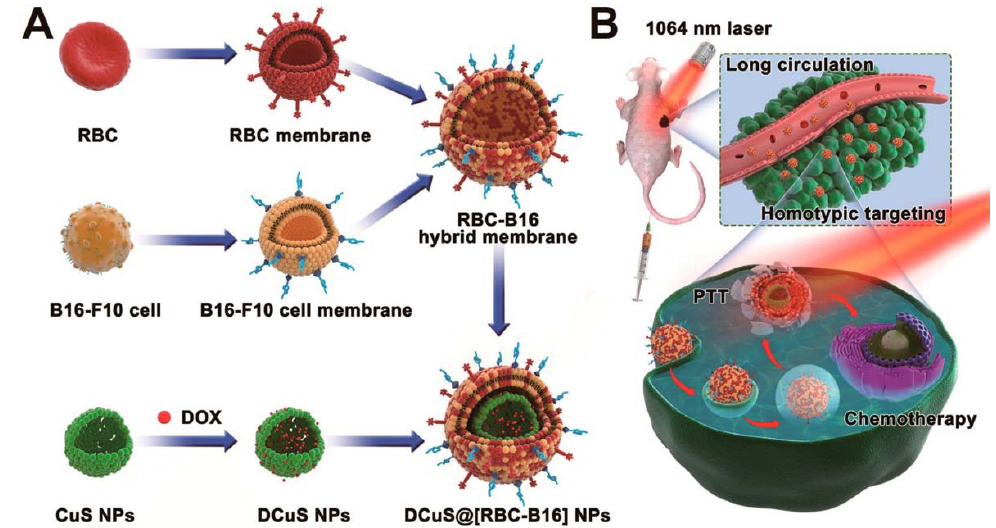
Figure 10. Schematic showing the fusion of RBC and cancer cell membranes and camouflaging Doxorubicin loaded hollow copper sulfide nanoparticles and its synergistic near infrared (NIR) laser‐triggered chemo/photothermal therapy. Reproduced with permission from reference [76]. Copyright © 2018, American Chemical Society.